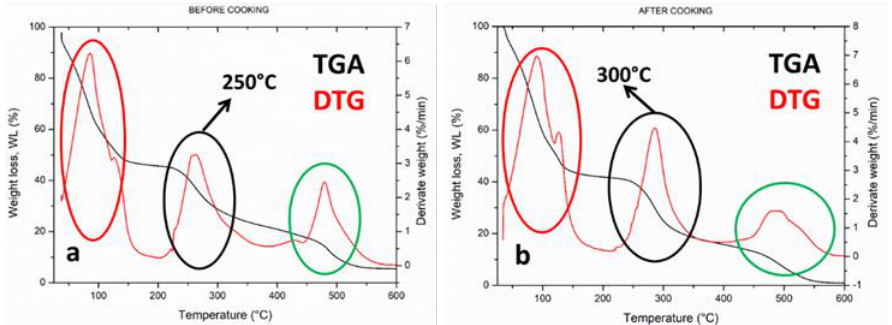
Figure 2. ( a ) TGA thermograms and ( b ) DTG curves of Gnocchi GSW before and after cooking.